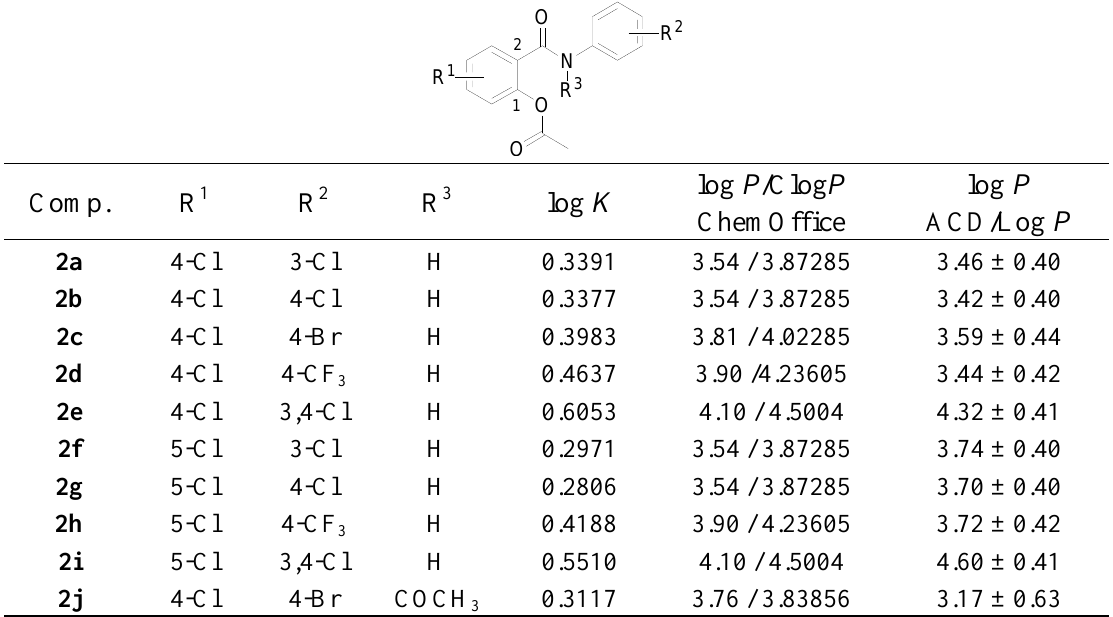
Table 2. Comparison of the determined log K values with the calculated lipophilicities (log P /Clog P ) of the synthesized ring substituted salicylanilide acetates 2a - 2j .